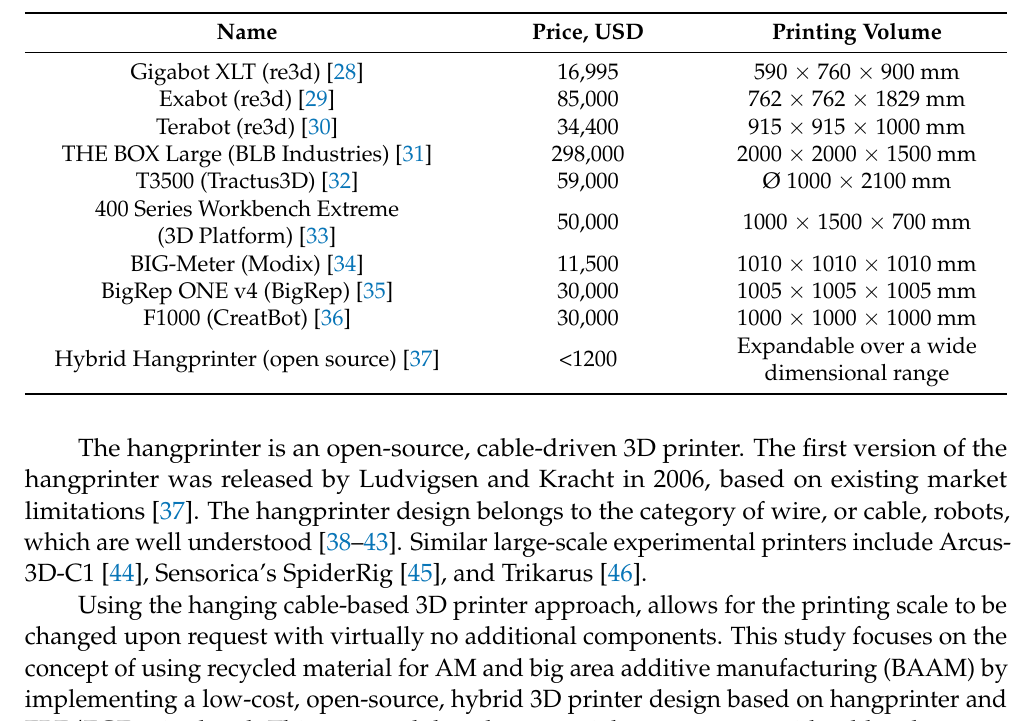
Table 1. Comparison of cost and print volume of existing large 3D